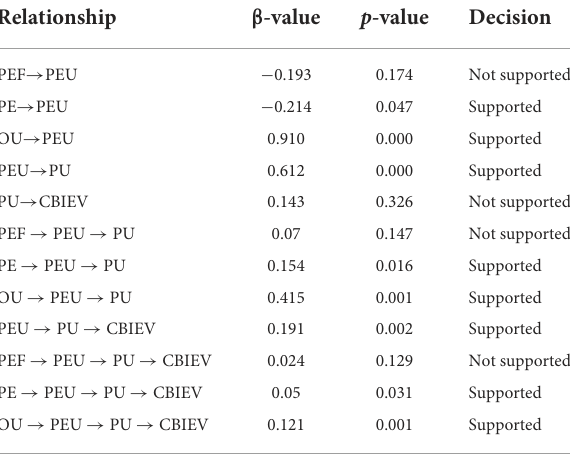
TABLE 8 Permutation test path coefficient